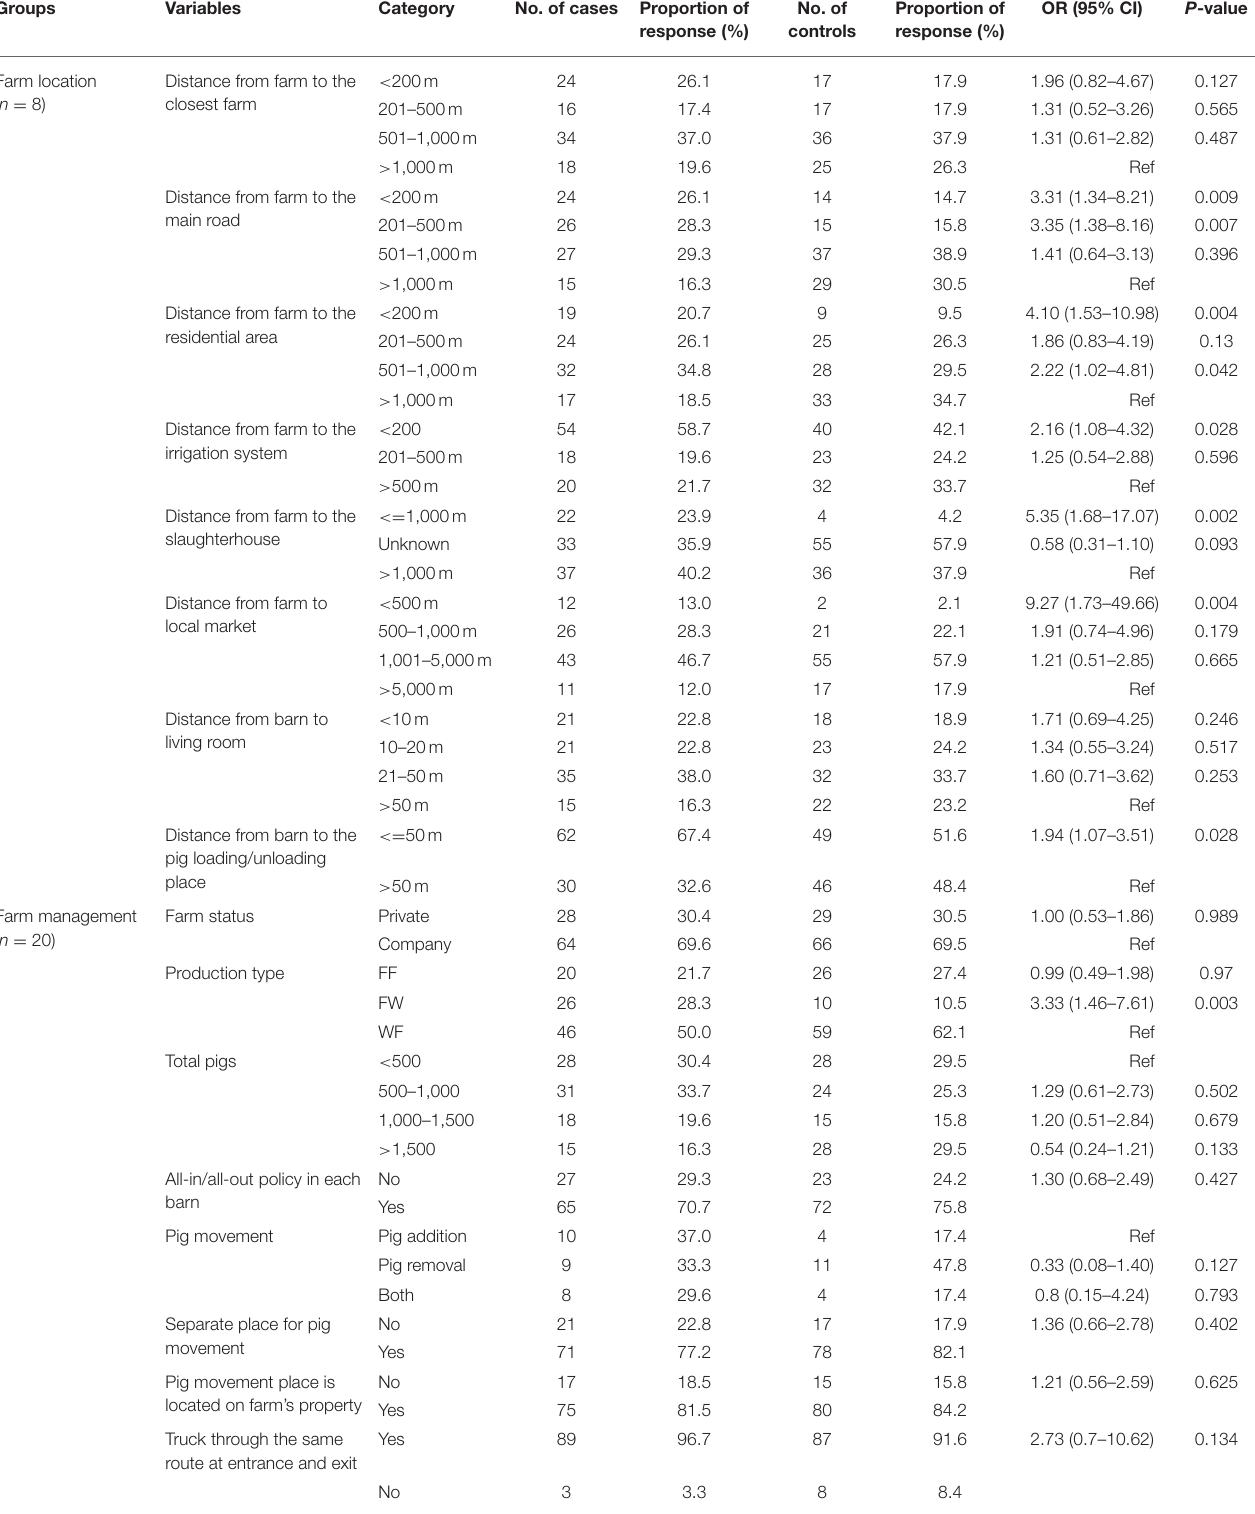
TABLE 1 | Results of a univariate analysis of location variables in the risk of Porcine epidemic diarrhea virus infection in a case–control study of northern Vietnamese pig farms in 2018. Groups Variables Category No. of cases Proportion of